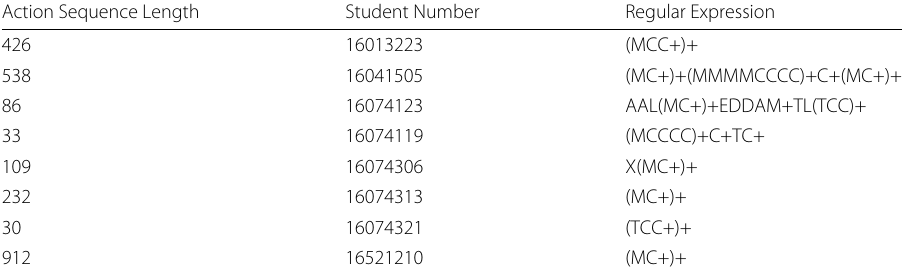
Table 4 Regular Expressions of Action Sequences Action Sequence Length Student Number Regular